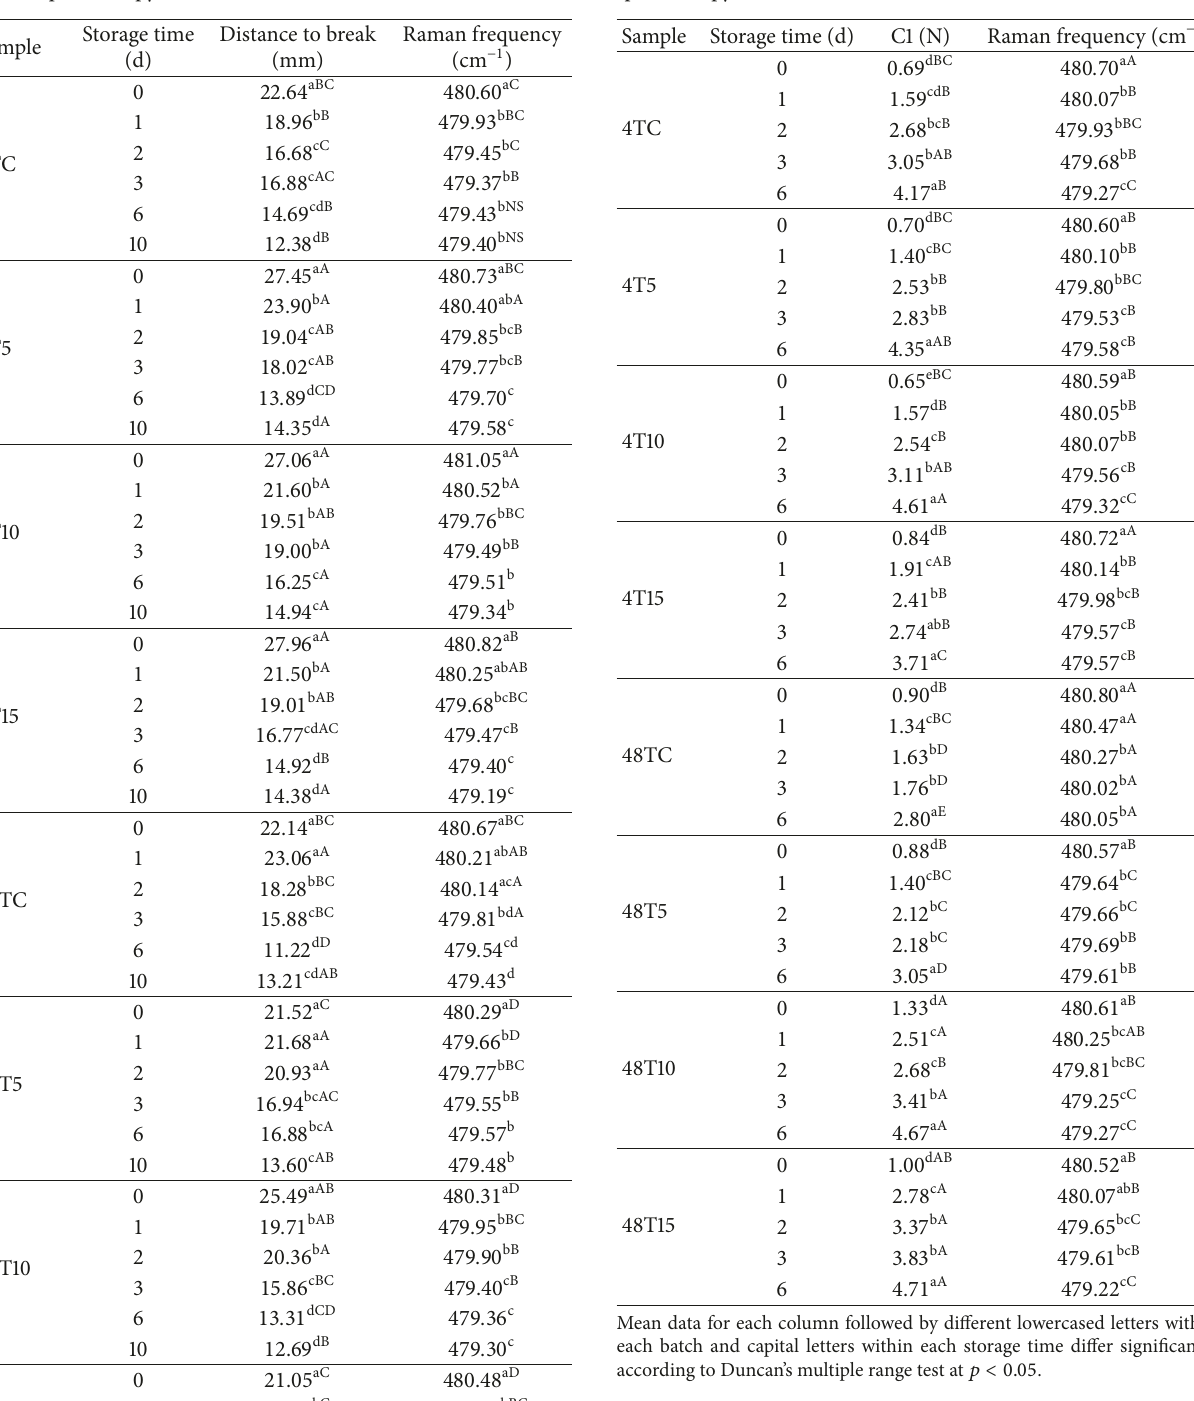
Table 4: Staling of Spianata bread: data from texture analysis and Raman spectroscopy.